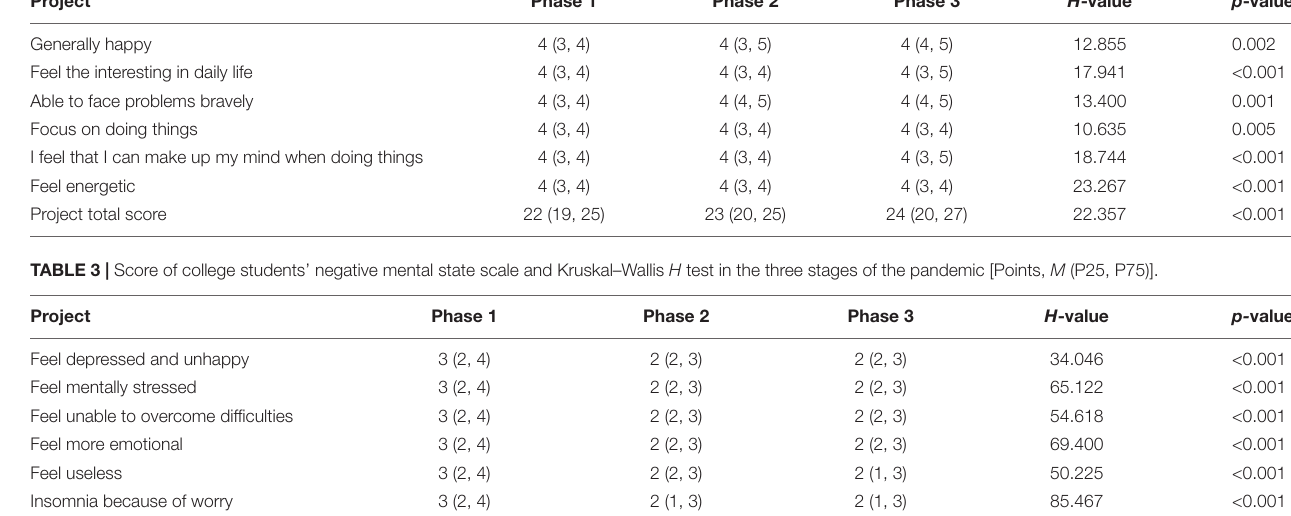
TABLE 2 | Score of college students’ positive mental state scale and Kruskal–Wallis H test in the three stages of the pandemic [Points, M (P25, P75)]. Project